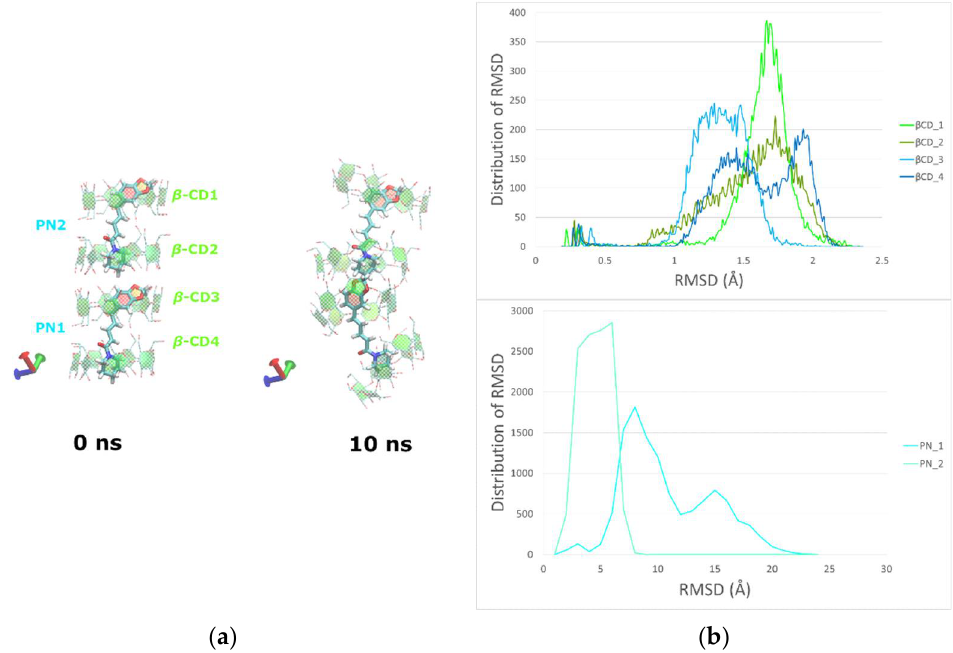
Figure 6. ( a ) Representative snapshots of PN/ β -CD at 0 and 10 ns. ( b ) The distribution analysis of RMSD values for the four host ( β -CD1, β -CD2, β -CD3 and β -CD4) and two guest (PN1 and PN2) molecules.